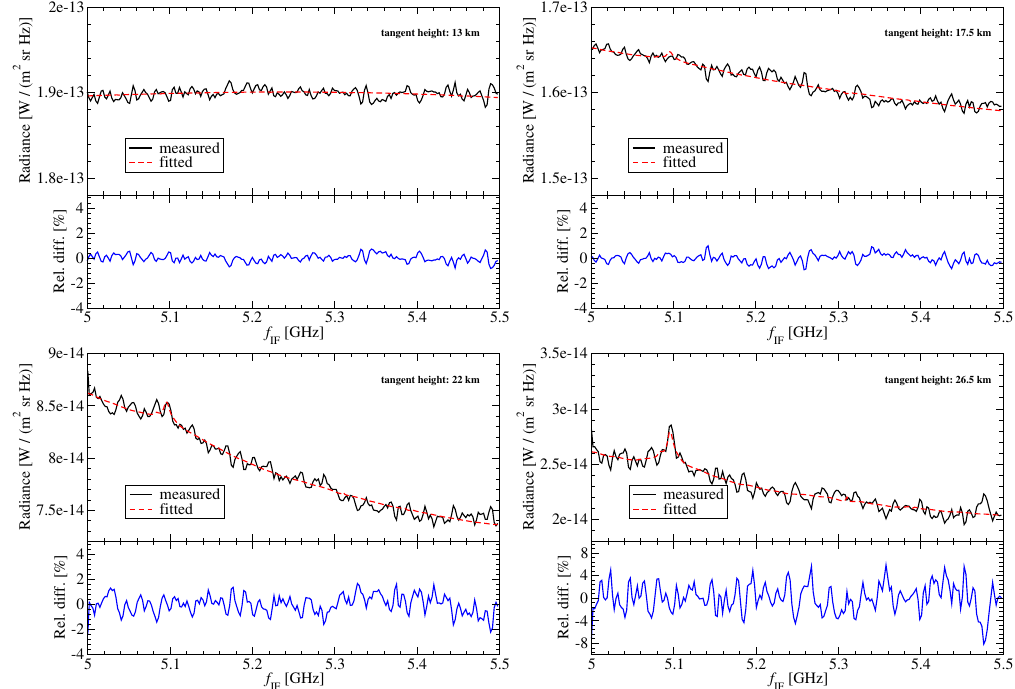
Figure 17. Comparison of measured and modeled TELIS OH spectra in segment 3. The dedicated measurement identifier is 10890 during the 2009 flight and the corresponding f LO is 1829.6524GHz. The spectra are plotted for tangent heights of 13km, 17.5km, 22km, and 26.5km.